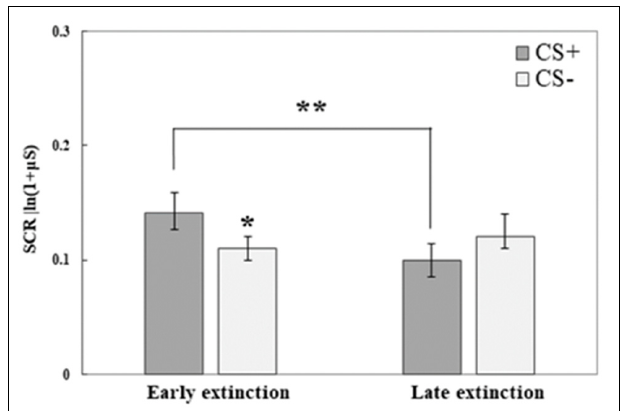
FIGURE 3 | Day 3: Fear extinction training took place on the third testing day. Here, both conditioned stimuli (CS+, CS − ) were presented (both not reinforced) for 10 times each. This graph illustrates mean ( ± SEM) SCR to both stimuli at early extinction (trials 1–5) vs. late extinction (trials 6–10). The significant difference between CS+ and CS − during early extinction ( ∗ p < 0.05) indicates fear memory retrieval (early extinction CS+: RE+CORT: 0.13 ± 0.03; RE: 0.14 ± 0.03; CORT: 0.15 ± 0.04; early extinction CS − : RE+CORT: 0.12 ± 0.03; RE: 0.11 ± 0.02; CORT: 0.12 ± 0.02); the significant reduction of response to the CS+ ( ∗∗ p < 0.01) and the lack of difference between the stimuli at the later phase indicate successful fear extinction (late extinction CS+: RE+CORT: 0.08 ± 0.02; RE: 0.13 ± 0.03; CORT: 0.09 ± 0.02; late extinction CS − : RE+CORT: 0.09 ± 0.03; RE: 0.14 ± 0.03; CORT: 0.12 ± 0.03). As no interaction or main effect of group were found, the graph presents the groups combined ( N = 74; RE+CORT group: n = 24, RE group: n = 25, CORT group: n =